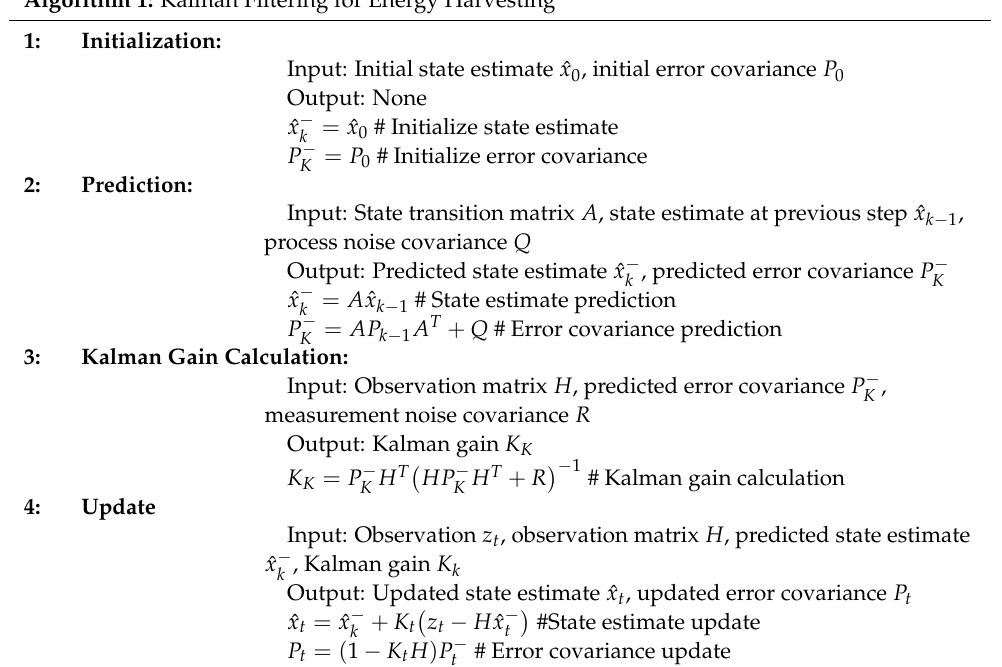
Algorithm 1: Kalman Filtering for Energy